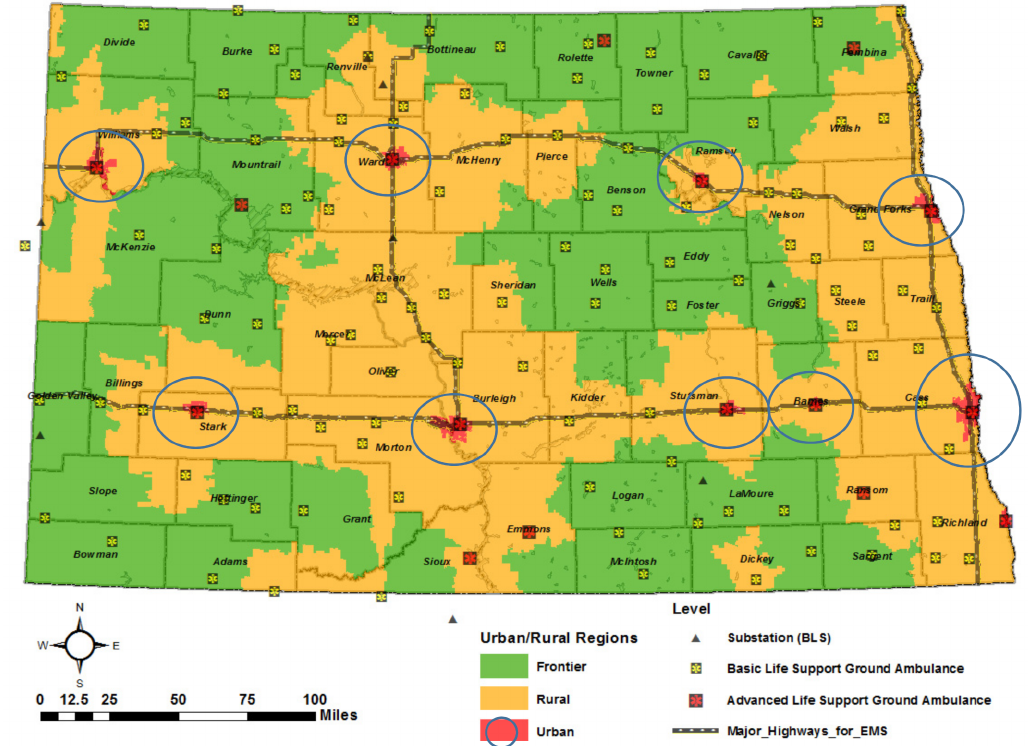
Figure 2. Urban, rural, and frontier regions by Census Block in North Dakota.